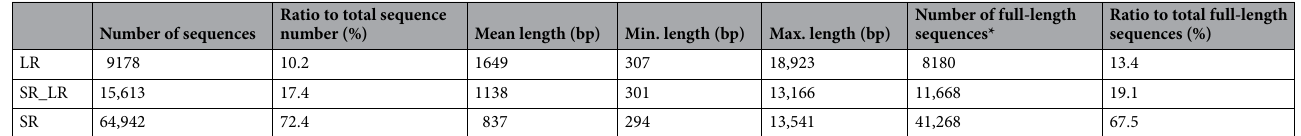
Table 5. Summary of the sequence origin in the Cmsa representative mRNA dataset. *Number of sequences predicted to have a start methionine and stop codon in the longest translation flame.